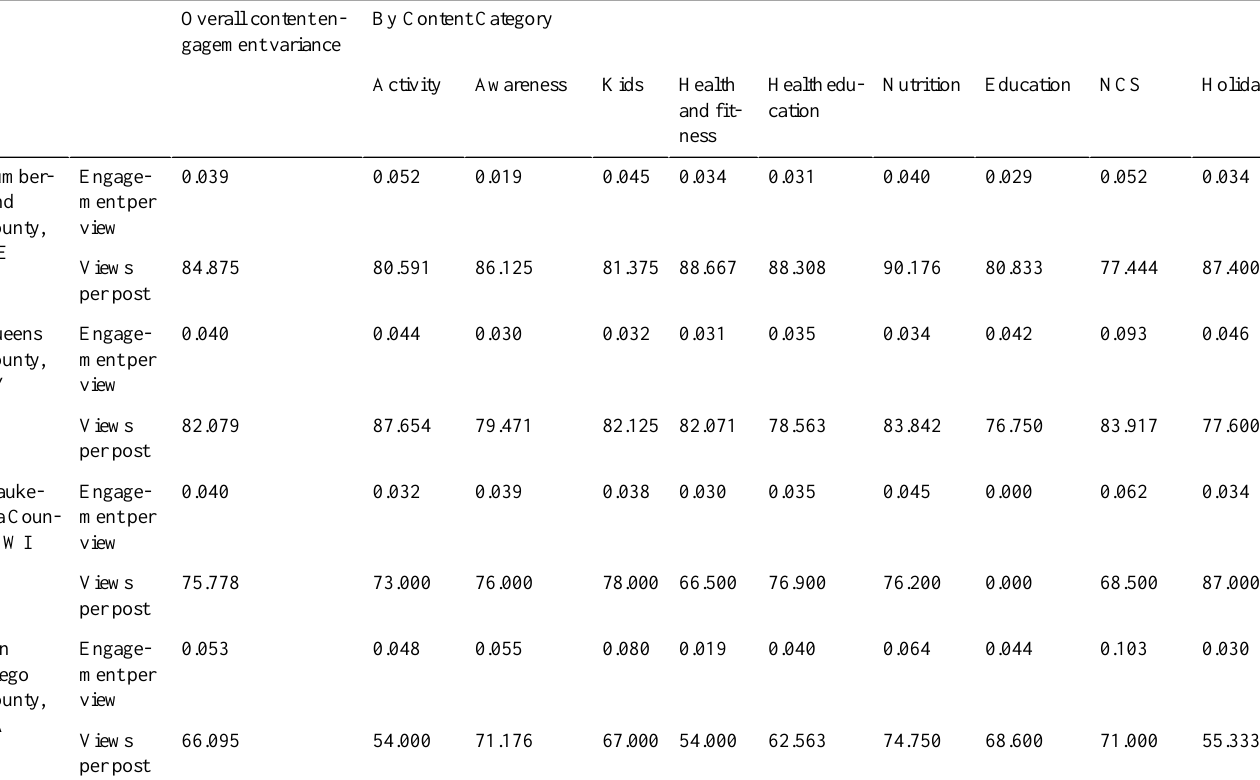
Table 2. Content engagement variance as a function of Study Center.